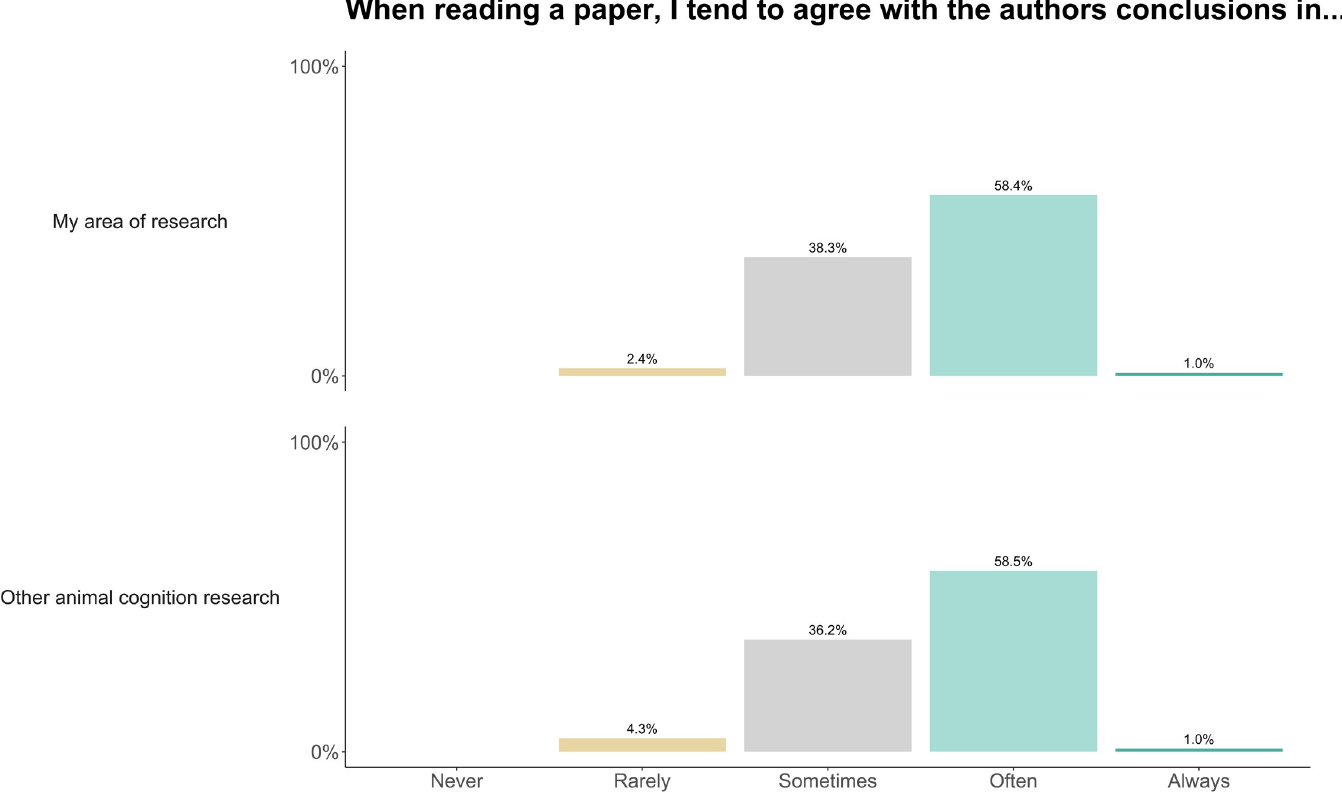
Fig 16. Animal cognition researchers’ tendency to agree with the conclusions of papers in their own and other areas of research. N =